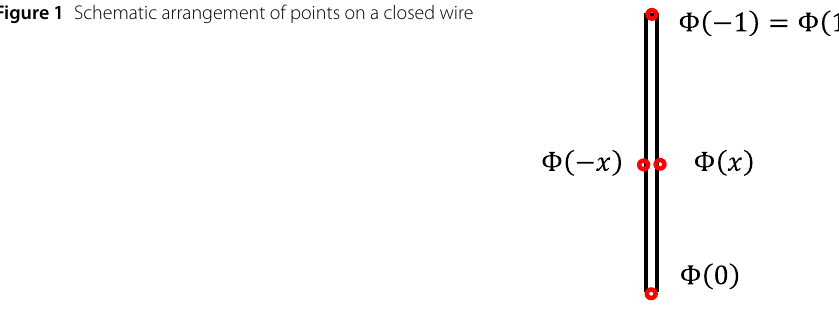
Figure 1 Schematic arrangement of points on a closed